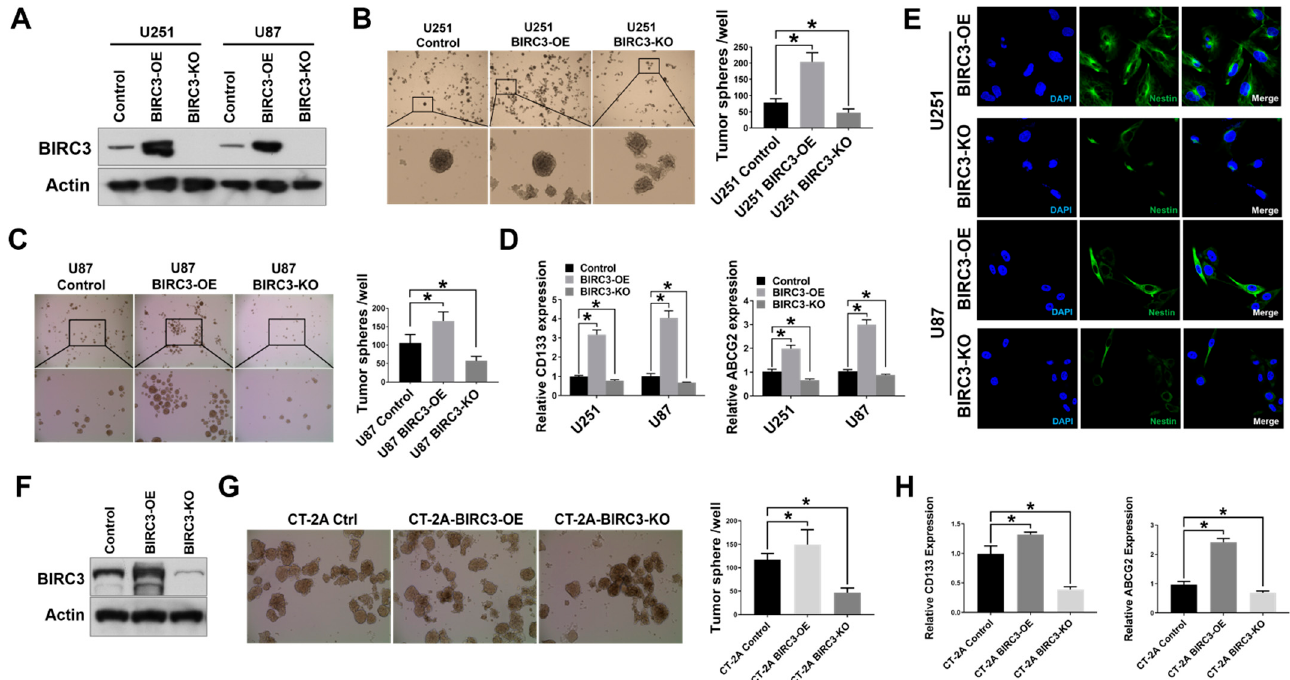
Figure 1. Expression of BIRC3 correlates with stem cell markers expression and self-renewal in both human and mouse GBM cells ( A ). Protein expression of BIRC3 in U251 and U87 GBM cells. Each cell line includes control, BIRC3 overexpression (BIRC3-OE) and BIRC3 knockout (BIRC3-KO) groups. Specific antibodies as indicated. β -actin acts as internal control. ( B , C ). Control, BIRC3-OE or BIRC3-KO of U251 and U87 cells were seeded in 6 well plates and cultured in neurosphere formation medium. The number of neurospheres were observed and calculated under